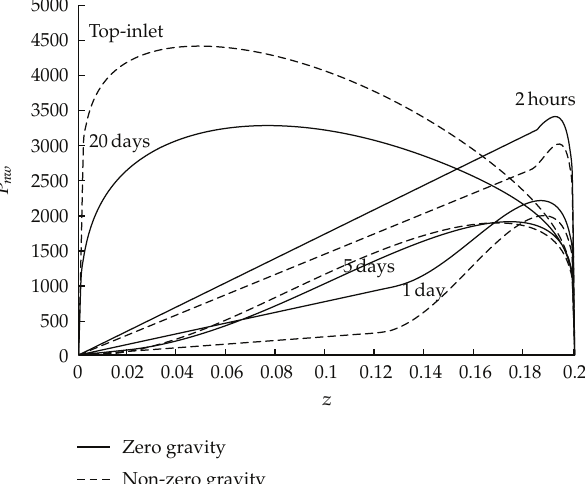
Figure 11: Comparison between considering and neglecting gravity e ff ect on oil pressure for the top-inlet case, at x (cid:8) 0 .